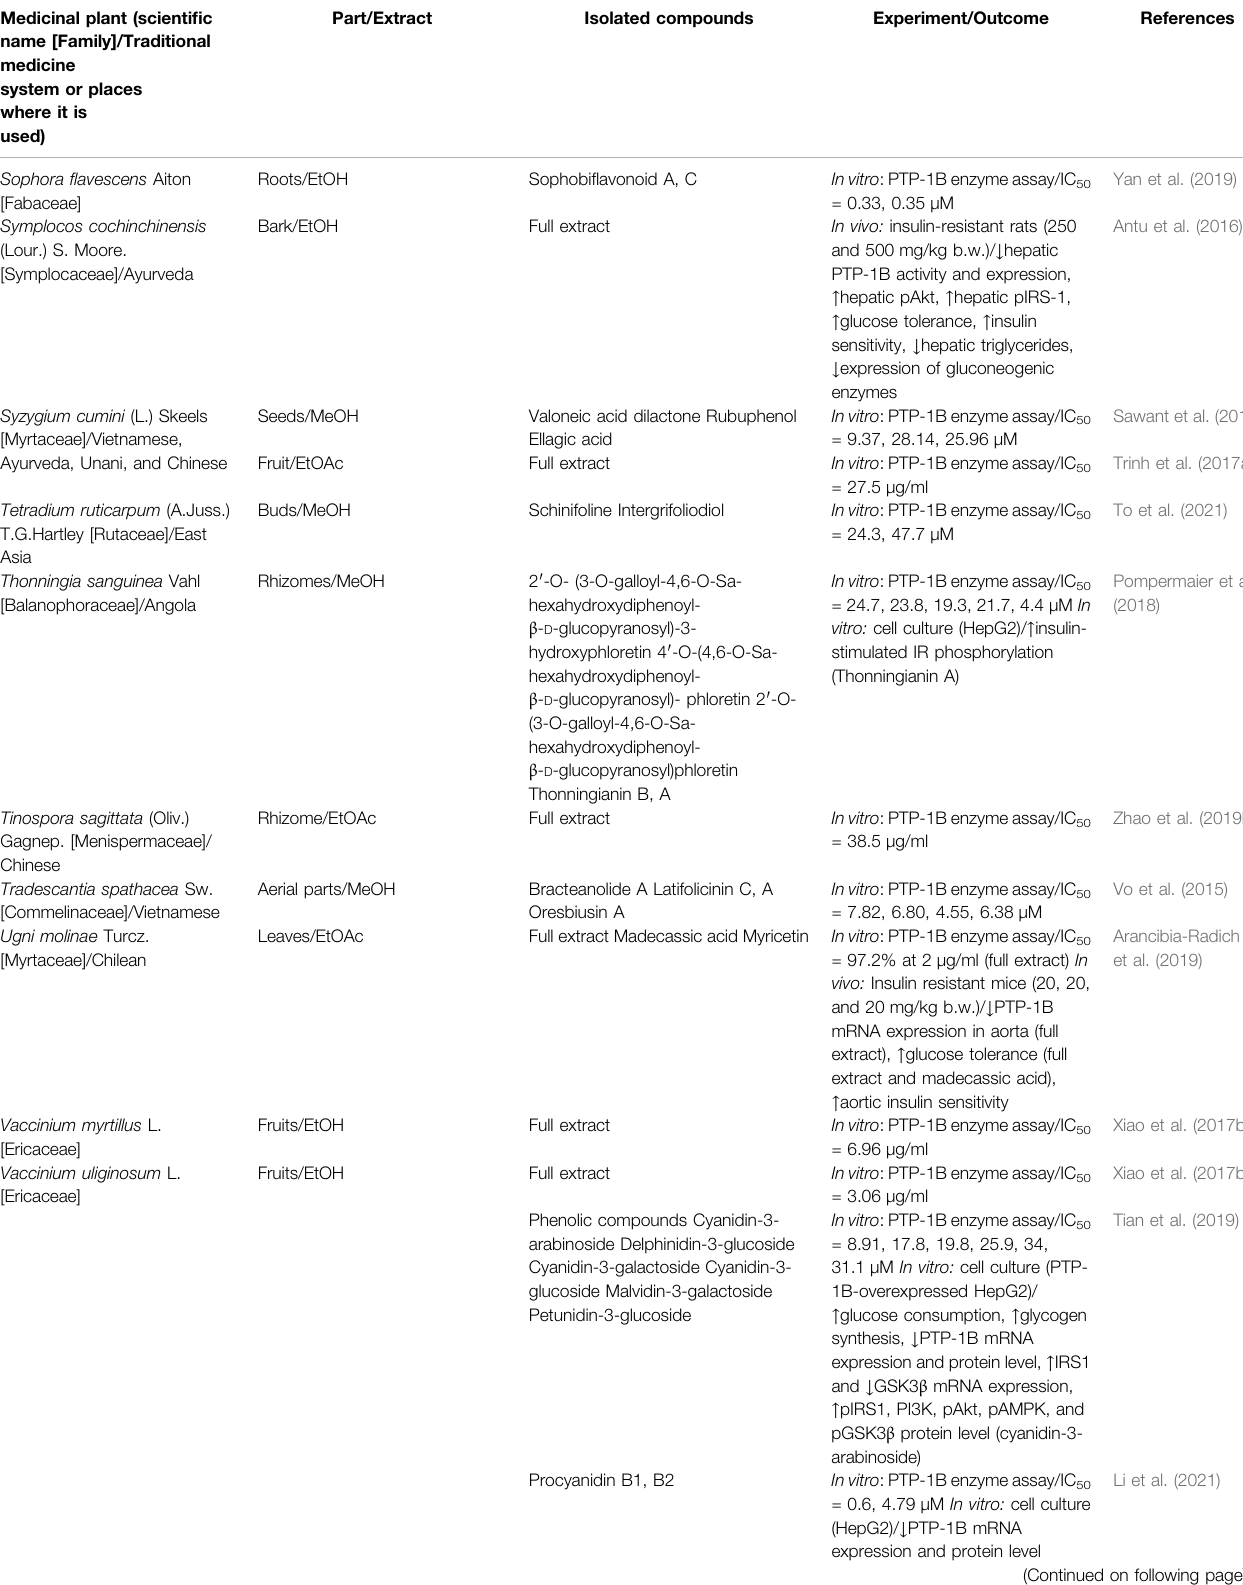
Medicinal plant (scienti fi c name